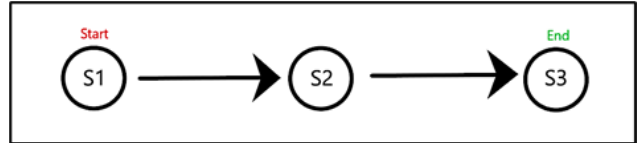
Figure 5. Layout of the simulated path in a straight line.